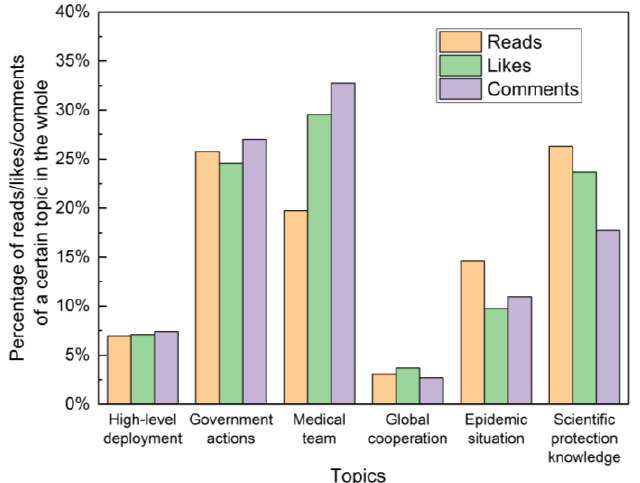
Figure 3. The trend of public ’ s attention (reads, likes and comments) in different topics.